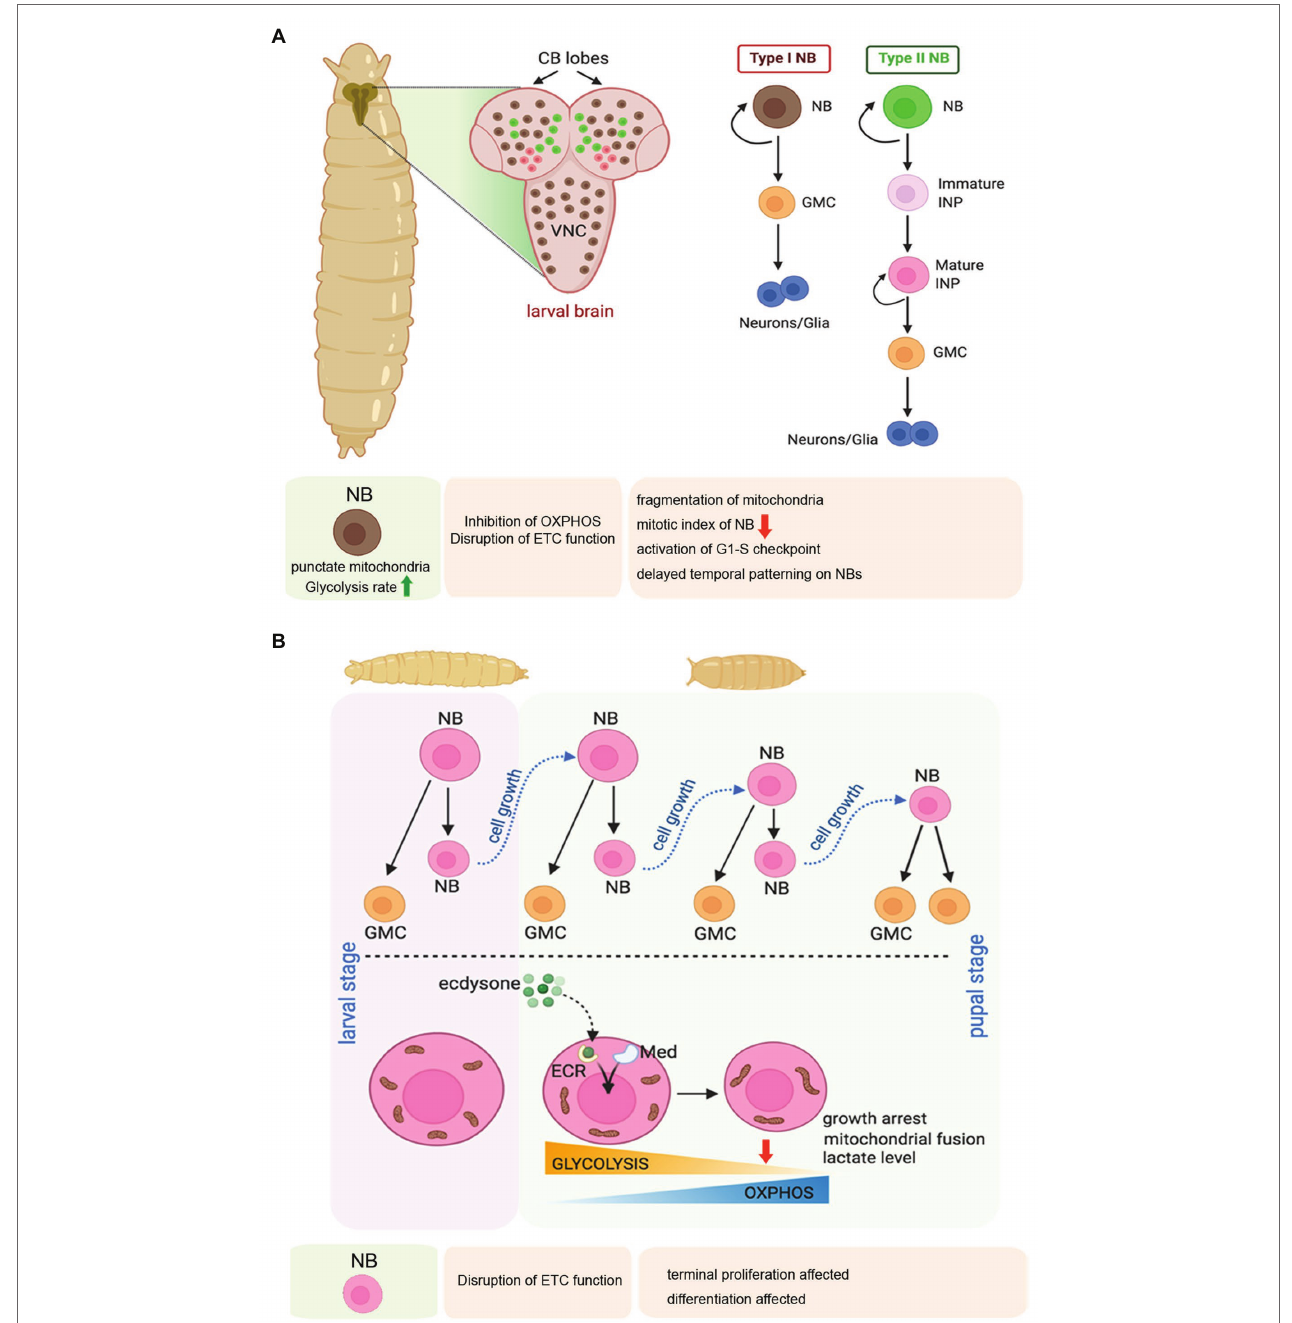
FIGURE 4 | Mitochondrial regulation of larval neuroblast (NB) proliferation, and terminal differentiation of NBs during early pupal stage in Drosophila . (A) Schematic representation of the larval brain showing the relative position of Type 1 and Type 2 NBs, and their pattern of self-renewal and differentiation. The expanded forms of the acronyms used are provided in the text. Table showing the effects of disrupting mitochondrial function in the larval NBs. (B) Schematic representation of the changes in mitochondrial morphology and function associated with NB growth arrest and terminal differentiation at the larval to pupal